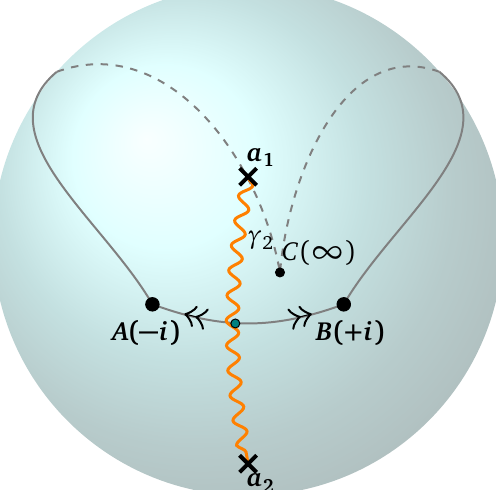
Figure 5.7: For q > 1, the N punctures localize, in the large N limit, on the single cut between a and a shown by the orange wavy line. Here C repels these N punctures, 1 2 while A , B still continue to attract them as in the previous